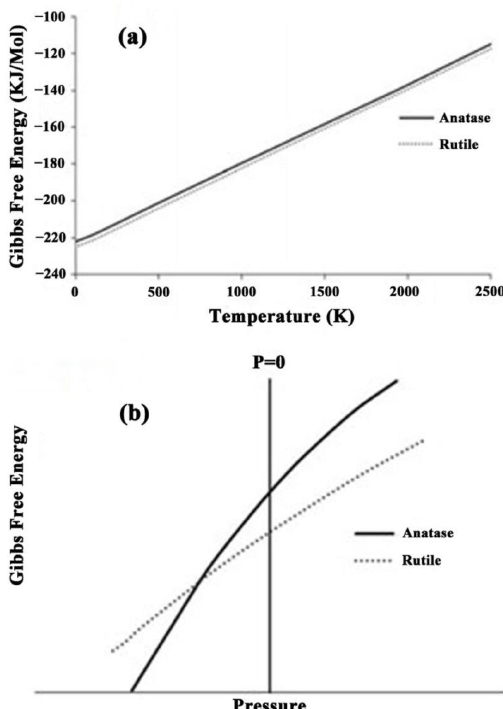
Figure 7. Plots of Gibbs free energy of anatase and rutile versus ( a ) temperature and ( b ) pressure (at room temperature). Reprinted with permission from Ref. [92]. Copyright 2011, Springer. Bulk and/or surface doping of TiO 2 could affect the stability of anatase and rutile phases and change the temperature of the transition of anatase to rutile, which has been explained by a ceased crystal growth as the result of the formation of Ti-O-M bonds. For instance, doping with metal cations including Nd [162], La [163], Ni [164], Si, W, Cr [165], Al, Nb, Ga, and Ta [166] could retard the grain/particle growth of anatase and rutile phases and delays the transition of anatase to rutile. The addition of molybdenum and tungsten could completely eliminate the anatase phase at temperatures between 680 and 830 °C, respectively [102]. Doping with V, Ag, Mn [165], Zn, Fe and Cu [166] could gener- ally promote this transformation. However, there are some dual behaviors which should be considered. For example, Wang et al. have reported the acceleration of anatase to rutile phase transition for Nb-doped TiO 2 . It is while a depression effect has been observed on the grains growth of anatase for Nb-doped TiO 2 [165]. Using cationic/anionic dopants [167] and non-metal dopants, including carbon [168], nitrogen [169], fluorine [170,171] and chlorine [171] could affect the phase transformation of titania. Unlike interstitial atoms that could increase the strain energy that must be overcome and the bonds that must be broken, the creation of oxygen vacancies, originated from the incorporation of ions with relatively small ionic radius and lower valence than that of Ti 4+ , could facilitate the phase transformation by reduction of the strain energy needed for the rearrangement of the Ti-